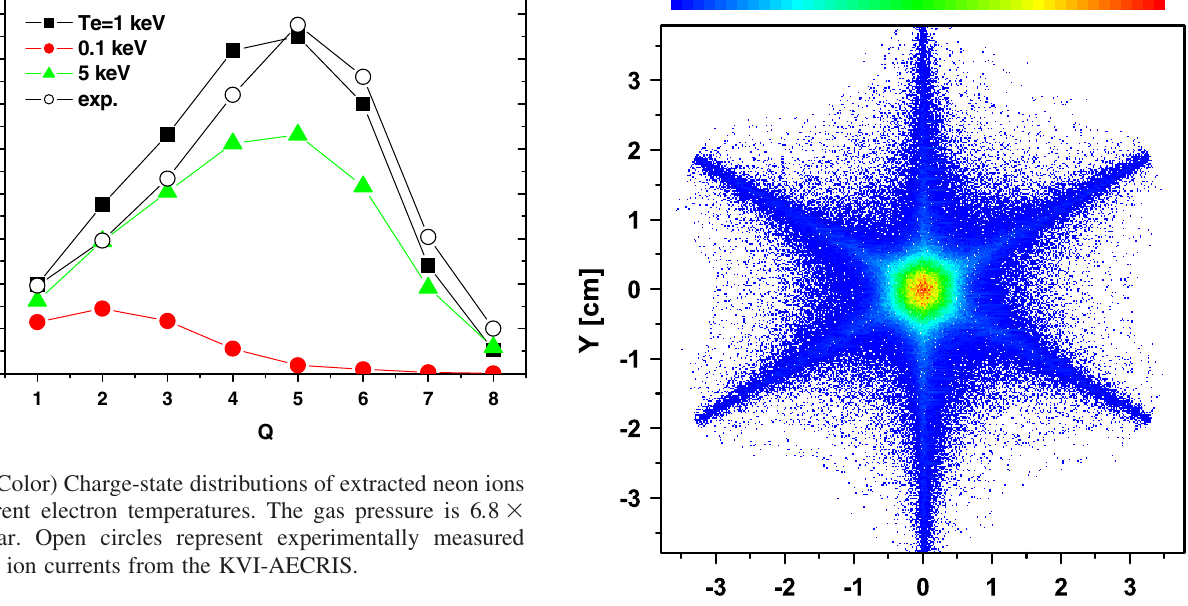
peaked at the plasma center.